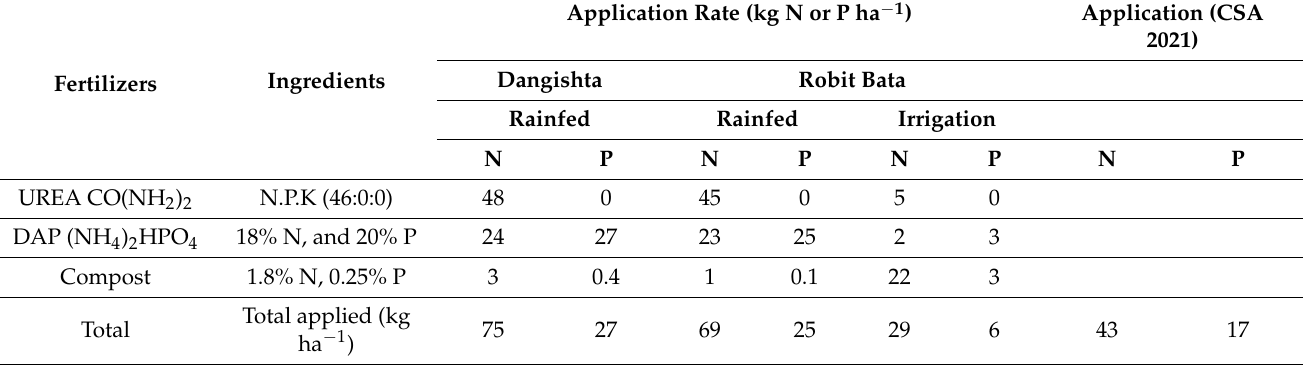
Table 1. Summary of fertilizers used and average N and P application rate in Dangishta and Robit